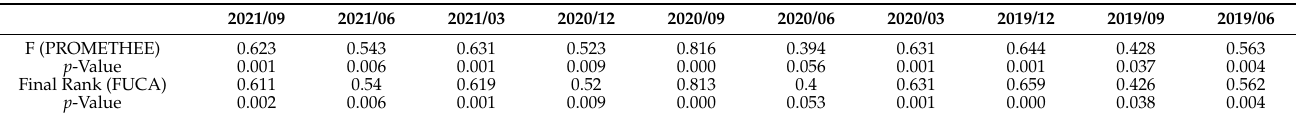
Table 14. MCDM Comparison Results by Spearman Rho Coefficient between FP and SR in 10- Quarters